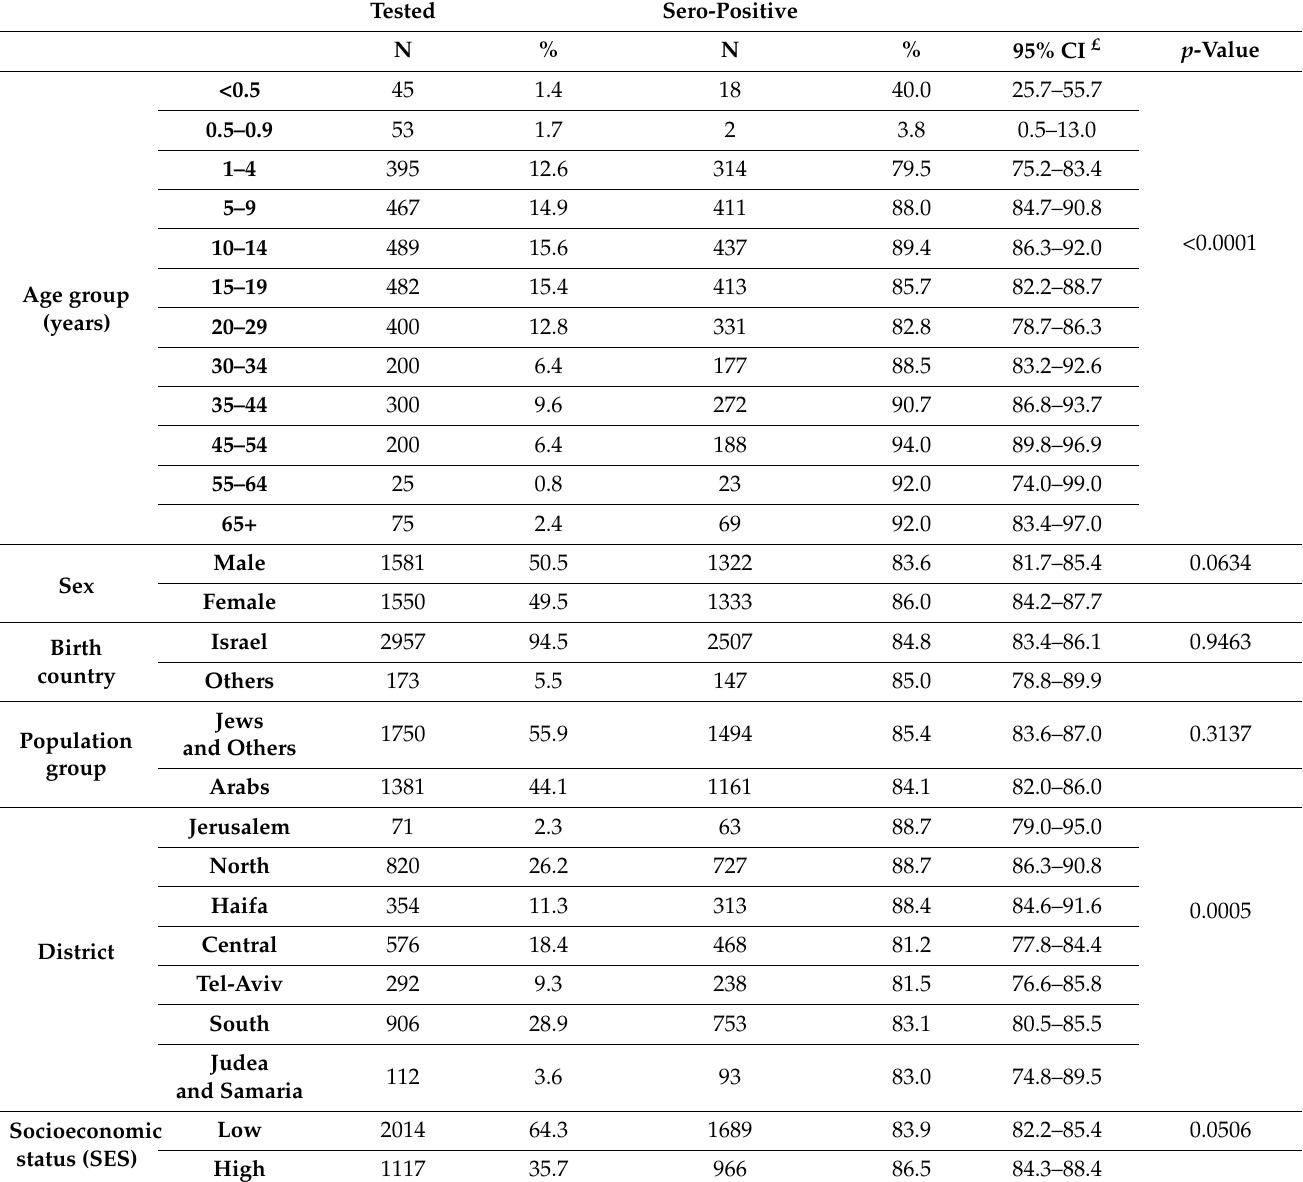
Table 1. Sero-positivity for mumps IgG antibodies by demographic characteristics in Israel, 2015 ( n =